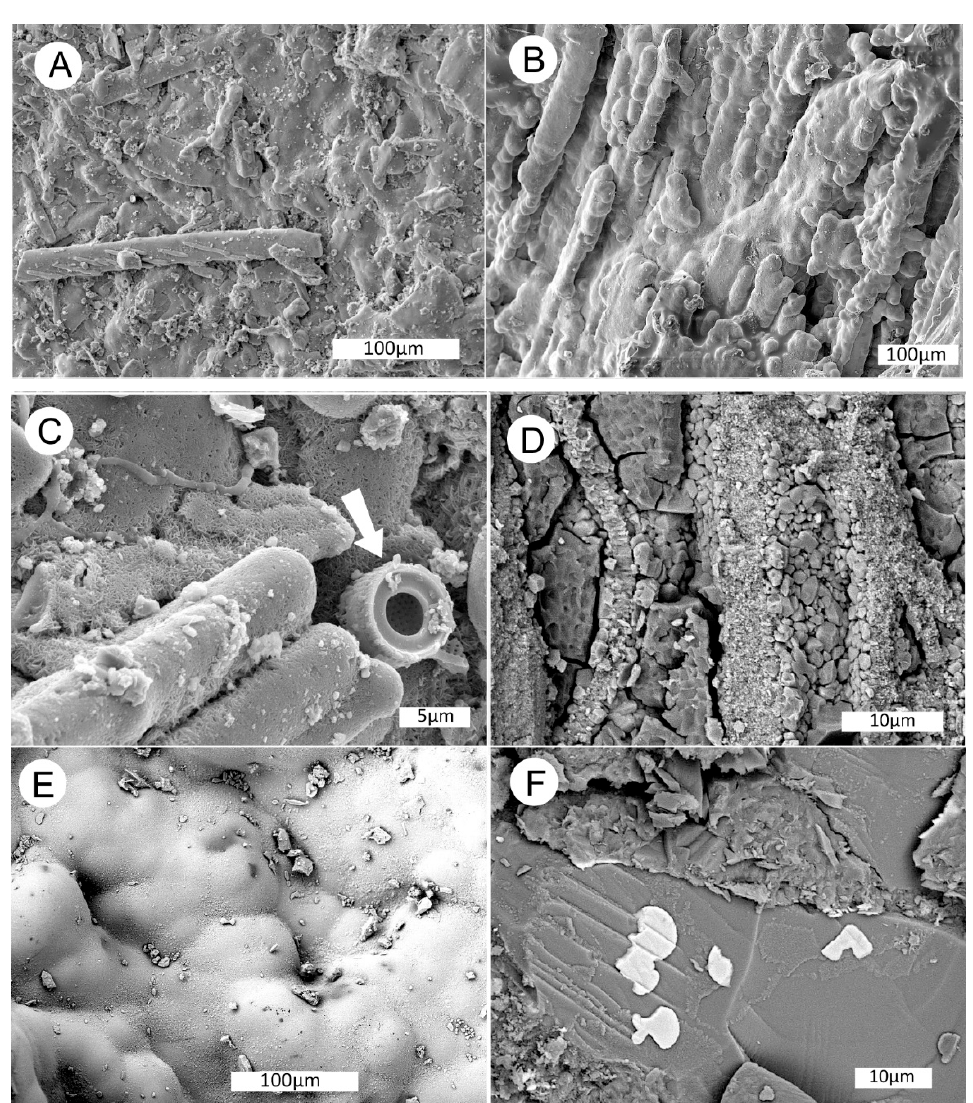
Figure 31. SEM images of specimen shown in Figure 29B. ( A ) SE image of small wood fragments in a matrix of common opal. ( B ) longitudinal view of wood cells encased in botryoidal opal. ( C ) High magnification SE image of opal-coated wood cells, Arrow shows end view of a diatom frustule. Crystalline structure of Opal-CT is visible on background surfaces. ( D ) Fractures in dessicated opal are filled with microcrystalline quartz. ( E ) BSE image of botryoidal opal on exterior surface of specimen. ( F ) BSE view showing an unidentified vanadium minera deposited on the surface of a plagioclase feldspar clast. Similar vanadium inclusions occur in the adjacent opalized wood. SEM/EDS evidence (Figure 32) suggest possibilities that include hewettite CaV 6 O 16 ·H 2 O, melanovanadite